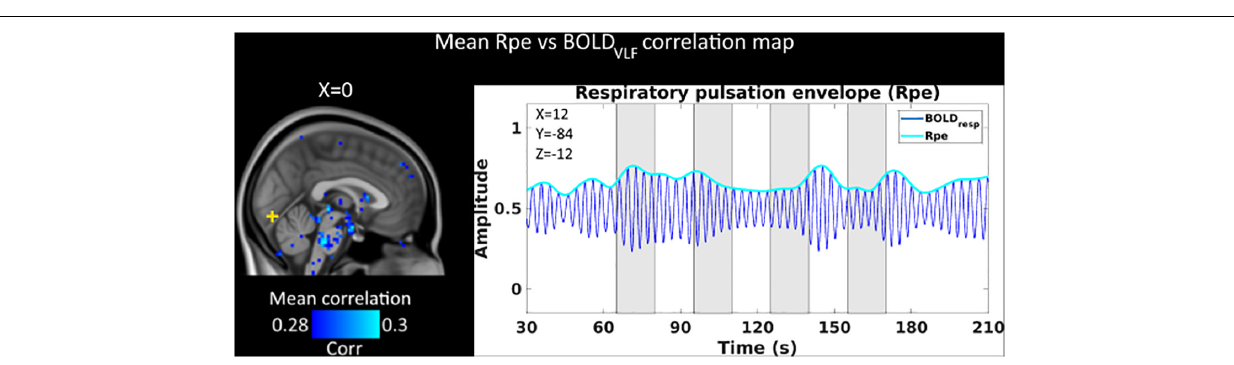
FIGURE 4 | Mean ( n = 23) within-voxel correlation map between BOLD VLF and respiratory pulsation envelope (Rpe). We see within-voxel correlations between Rpe and BOLD VLF in detecting respiratory modulations of the BOLD signal near the brainstem respiratory centers. There was no correlation between Rpe and BOLD VLF signal in the activated visual cortex (yellow cross). Visual stimuli are marked with